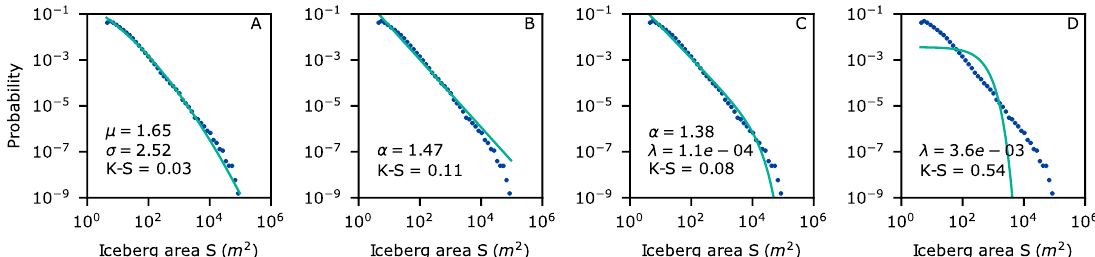
2 ) ; ( B ) power law P ( S = x ) = x α ; √ exp ( − ( lnx − µ ) 2 σ 2 x σ 2 π